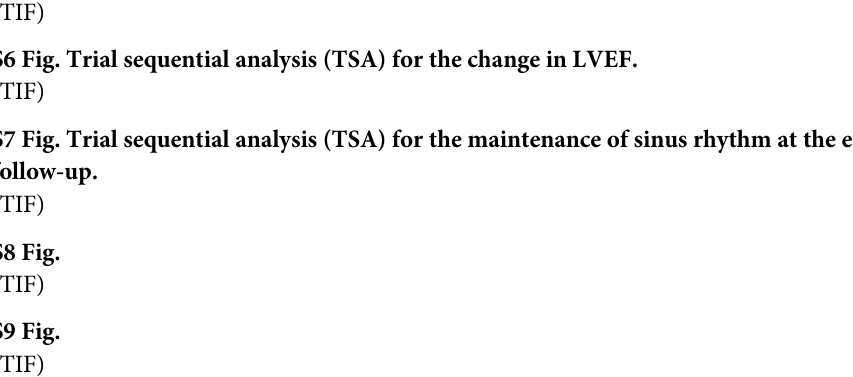
S5 Fig. Trial sequential analysis (TSA) for deaths. (TIF) S6 Fig. Trial sequential analysis (TSA) for the change in LVEF. (TIF) S7 Fig. Trial sequential analysis (TSA) for the maintenance of sinus rhythm at the end of follow-up. (TIF) S8 Fig. (TIF) S9 Fig. (TIF) S1 Table. PubMed search strategy for trials comparing atrial fibrillation ablation with drug therapy. S2 Table. Cochrane Central Register of Controlled Trials search strategy for trials compar- ing atrial fibrillation ablation with drug therapy. S3 Table. Embase search strategy for trials comparing atrial fibrillation ablation with drug